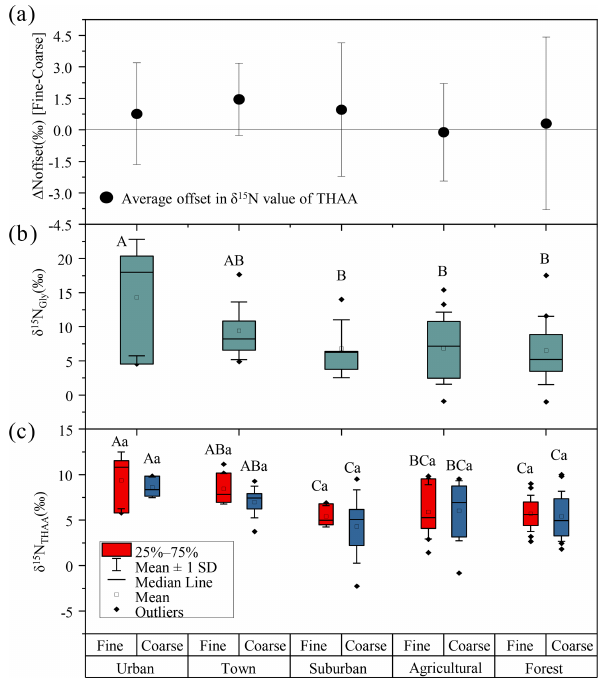
Figure 4. (a) The offset of δ 15 N THAA values between fine and coarse particles. (b) The δ 15 N Gly values of fine particles. (c) The δ 15 N THAA values of fine and coarse particles in urban, town, subur- ban, agricultural and forest sites. Different uppercase letters denote means found to be statistically different (Tukey-HSD test) between sites. Different lower case letters denote a significant difference be- tween fine and coarse particles. The error bars in (a) indicate the standard